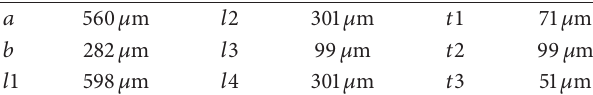
Table 2: Measured dimensions of the 10dB directional